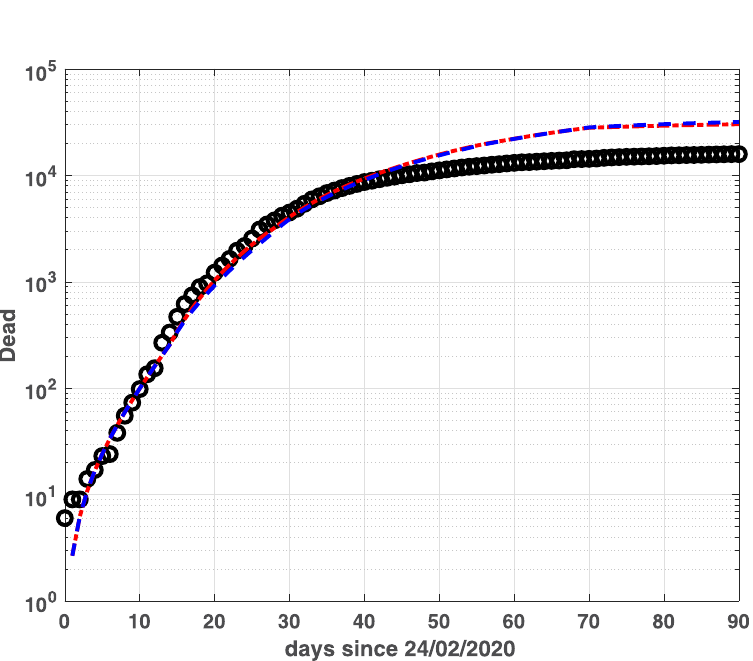
Fig 8. Recovered compartments for Lombardia. Dead data (black dots) and Dead modelled population, obtained by fSEIRDr (blue dash-dotted line) and fSEIDRe (red dashed line).